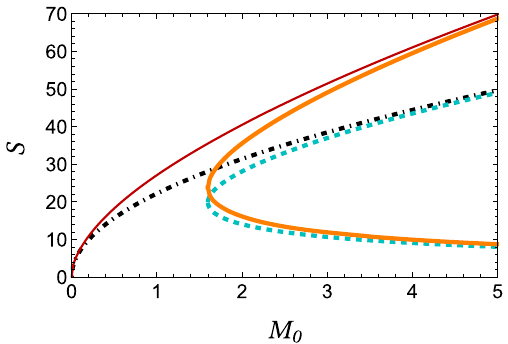
Fig. 4 The Hawking temperature T H as function of the classical mass M 0 for four different cases: (cid:12) = 0 and J 0 = 0 (dotted dashed black line), (cid:12) = 0 and J 0 = 8 (blue dashed line), (cid:12) = 0 . 1 and J 0 = 0 (solid thin red line) and (cid:12) = 0 . 1 and J 0 = 8 (solid thick orange line). In addition (cid:8) 0 = 5 and the values of the rest of the parameters have been taken as unity